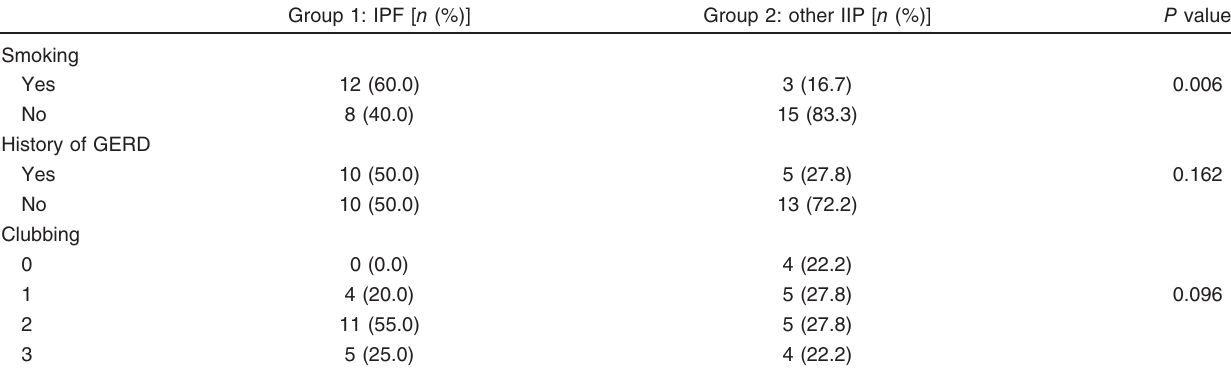
Table 2 Descriptive data for smoking history, gastroesophageal reflux disease history, and clubbing among idiopathic pulmonary fibrosis and other idiopathic interstitial pneumonia